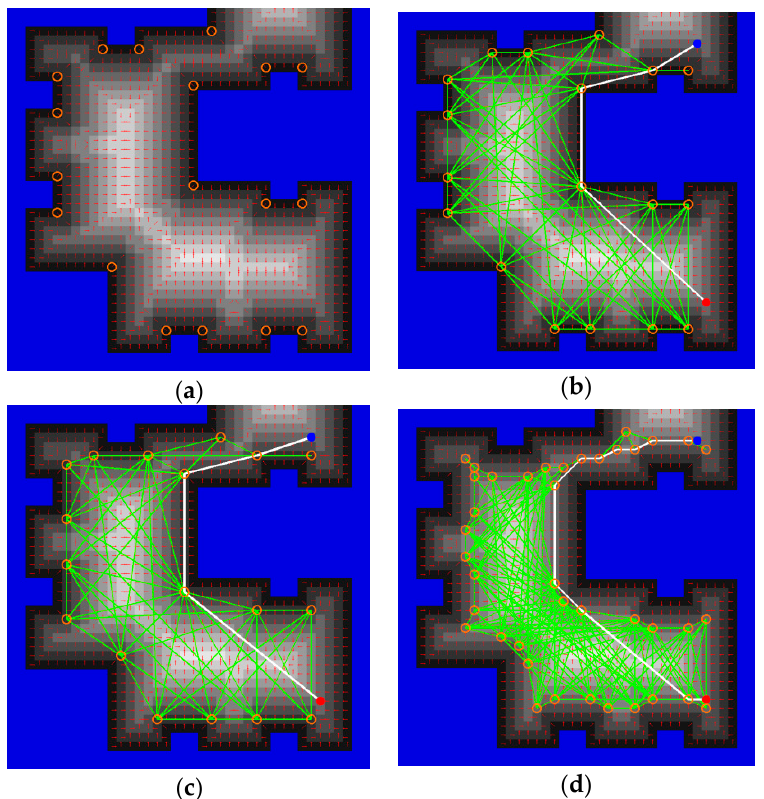
Figure 7. Steps of constructing DM-based subgoal graphs with different safety radius. ( a ) Step1: placing subgoals ( R = 1); ( b ) Step2: connecting direct-h-reachable subgoals ( R = 1); ( c ) a subgoal graph with R = 1.5; ( d ) a subgoal graph with R = 3.